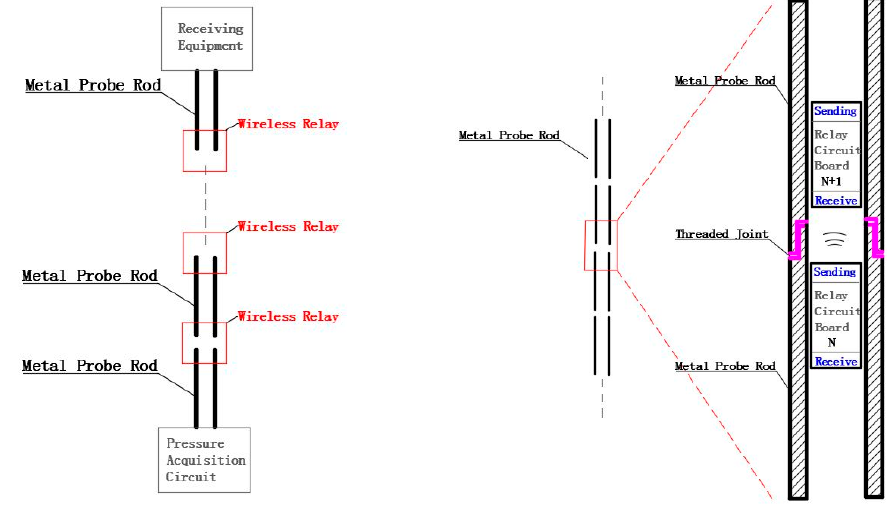
Figure 3. The diagram of the signal transmission process of the proposed system.